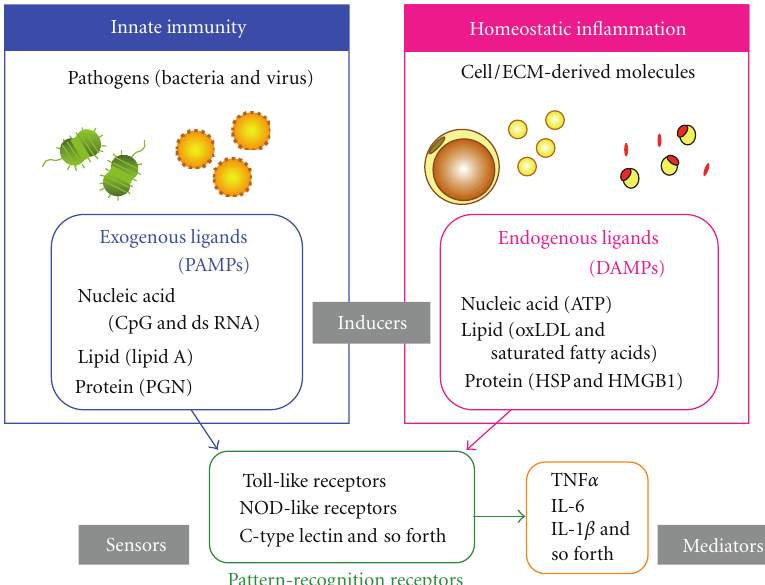
Figure 1: Adipose tissue inflammation as homeostatic inflammation. In innate immunity, exogenous ligands (pathogen-associated molecular patterns; PAMPs) are sensed by pattern-recognition receptors (PRRs), thereby inducing inflammatory changes. On the other hand, damage-associated molecular patterns (DAMPs) released from damaged or stressed cells and tissues can activate PRRs, thereby inducing homeostatic inflammation ranging from the basal homeostatic state to diseased tissue remodeling. For instance, free fatty acids (FFAs) released from hypertrophied adipocytes can report, as a danger signal, their diseased state to macrophages via Toll-like receptor 4 (TLR4) complex during the course of obesity. dsRNA, double-strand RNA; PGN, peptidoglycan; ATP, adenosine tri-phosphate; oxLDL, oxidized low-density lipoprotein; HSP, heat shock protein; HMGB1, high-mobility group box-1.